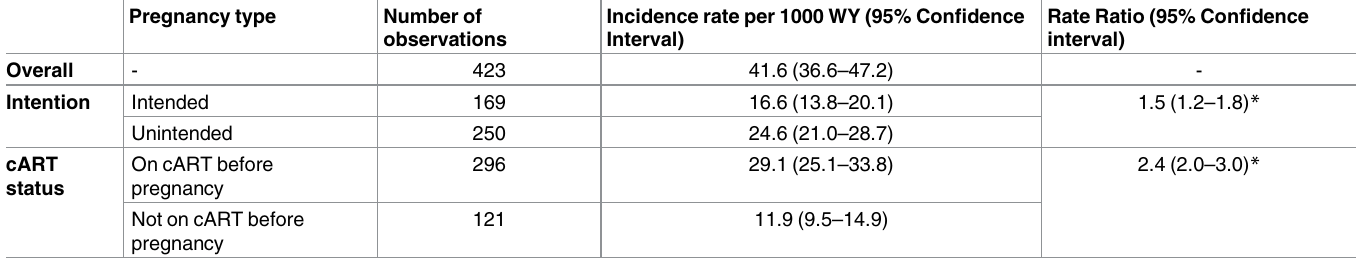
Table 2. GEE Poisson model to calculate pregnancy incidence rates, expressedasnumber of pregnancies per 1000 woman-years(WY) (95% confi- dence interval). Pregnancy